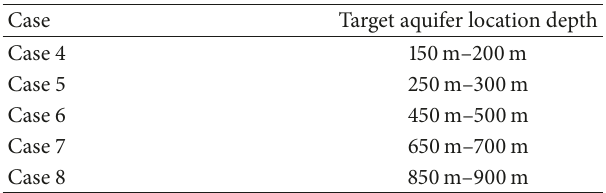
Table 3: Scenario sets for different target aquifer depths in a CAESA